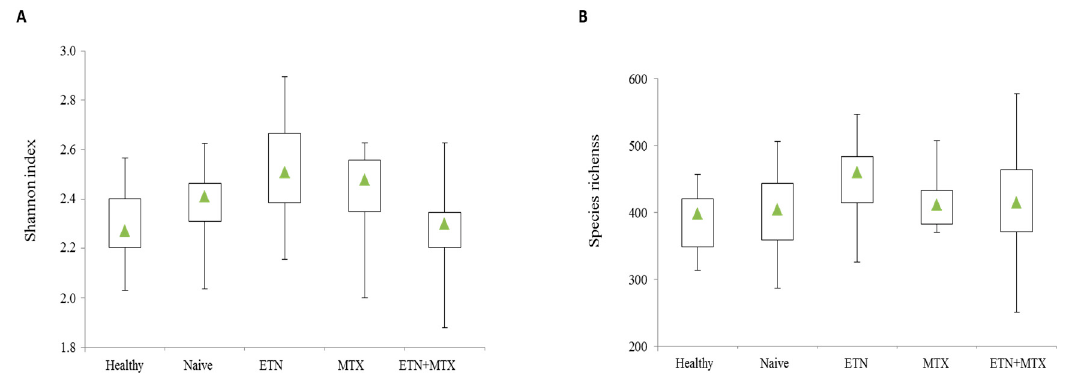
Figure 1. Box plots of Shannon diversity index ( A ) and species richness ( B ) of microbiota of healthy controls and different treatment groups of rheumatoid arthritis (RA) patients. The triangle represents the median value.